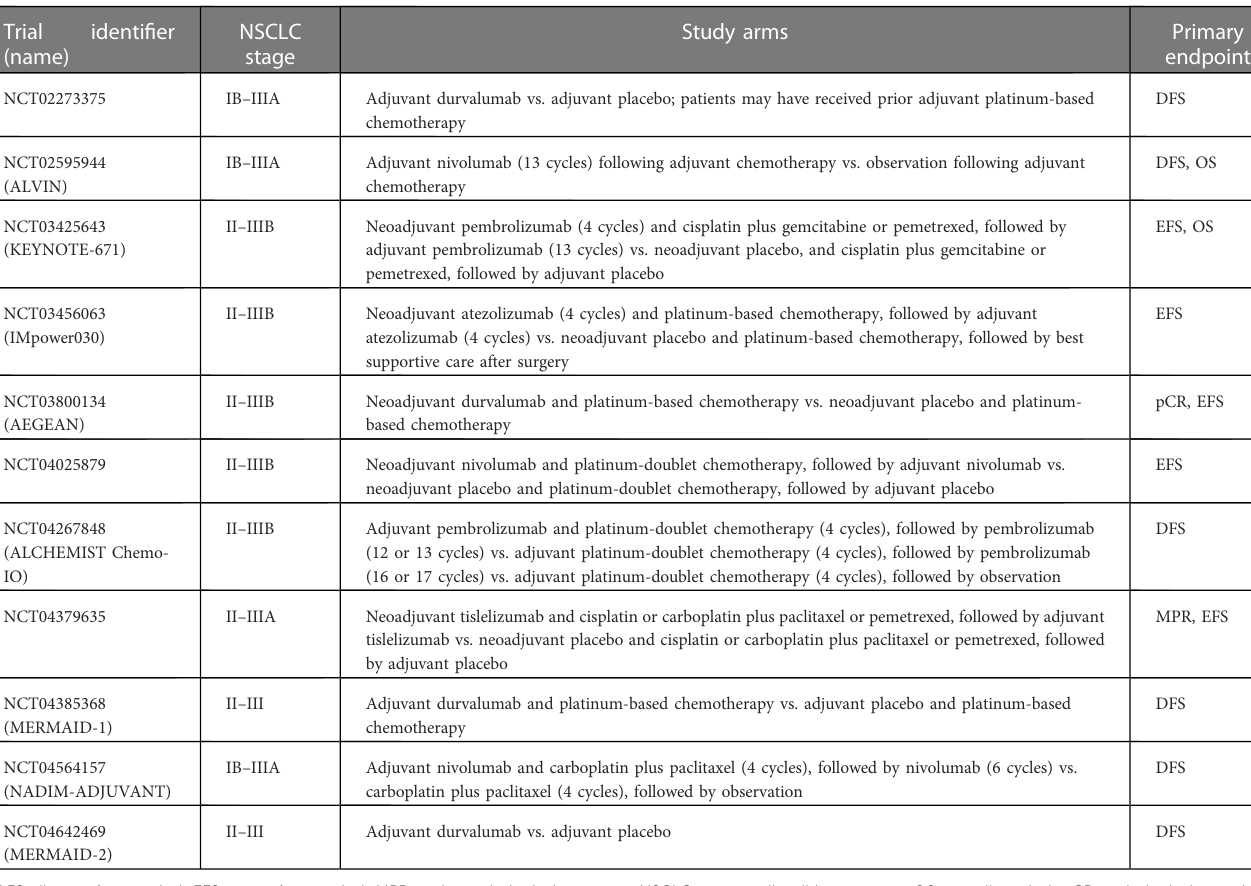
TABLE 1 Current phase 3 randomized clinical trials of immunotherapy as adjuvant and neoadjuvant treatment for non-small-cell lung cancer.